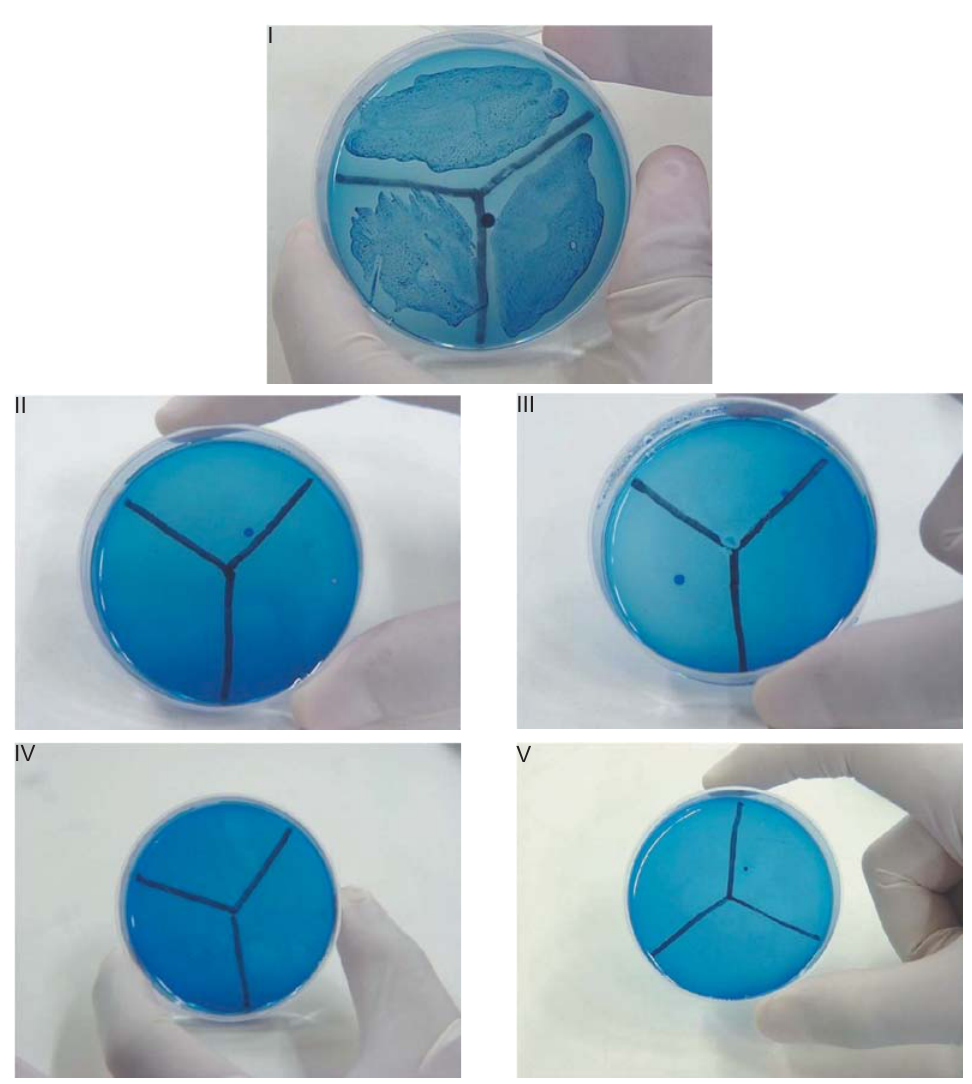
Figure 5- Characteristic of bacterial growth for group I, II, III, IV and V in the culture